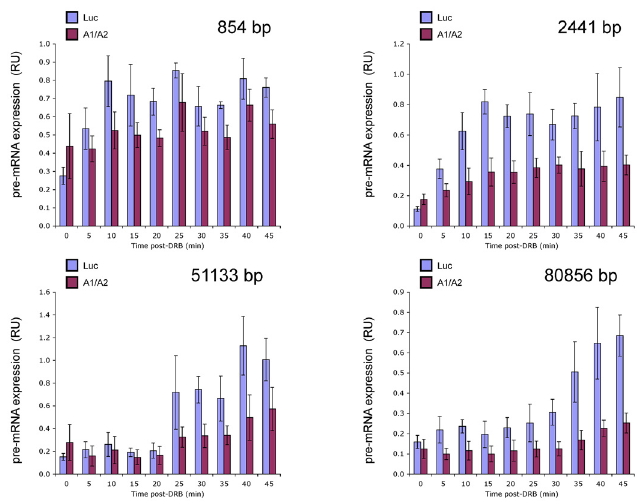
Fig 5. Transcription elongation recovery assay. Change in the rate of transcription of different portions of Kitlg upon depletion of A1 and A2 by RNAi. Seventy-two hours after transfecting a control siRNA against luciferase (Luc) or siA1 6 + siA2 1 (A1/A2) in HCT116 cells (H55-34 clone), DRB was applied, washed out, and the recovery of transcription was assessed at different positions. Each graph illustrates the position analyzed and the level of RNA at each time after the DRB block was released. The graphs represent averages of three independent experiments and standard deviations are provided. The positions analyzed on Kitlg are shown schematically in the map provided in Fig